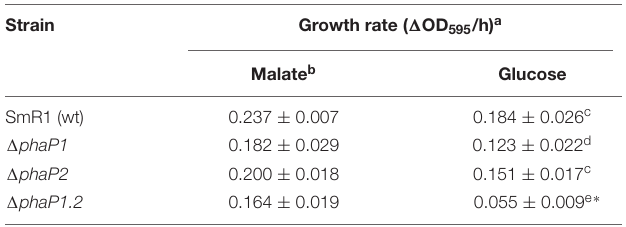
a The values are averages ± standard errors for two independent experiments. b Growth rate was calculated with the data of OD 600 between 8 and 13 h of growth for all strains. c Growth rate calculated between 10 and 16 h of growth. d Growth rate calculated between 12 and 19 h of growth. e Growth rate calculated between 7 and 16 h of growth. Where appropriate, statistical significance is shown ( ∗ p- value ≤ 0.05). The data obtained to the SmR1 strain was used for normalization and determination of statistical